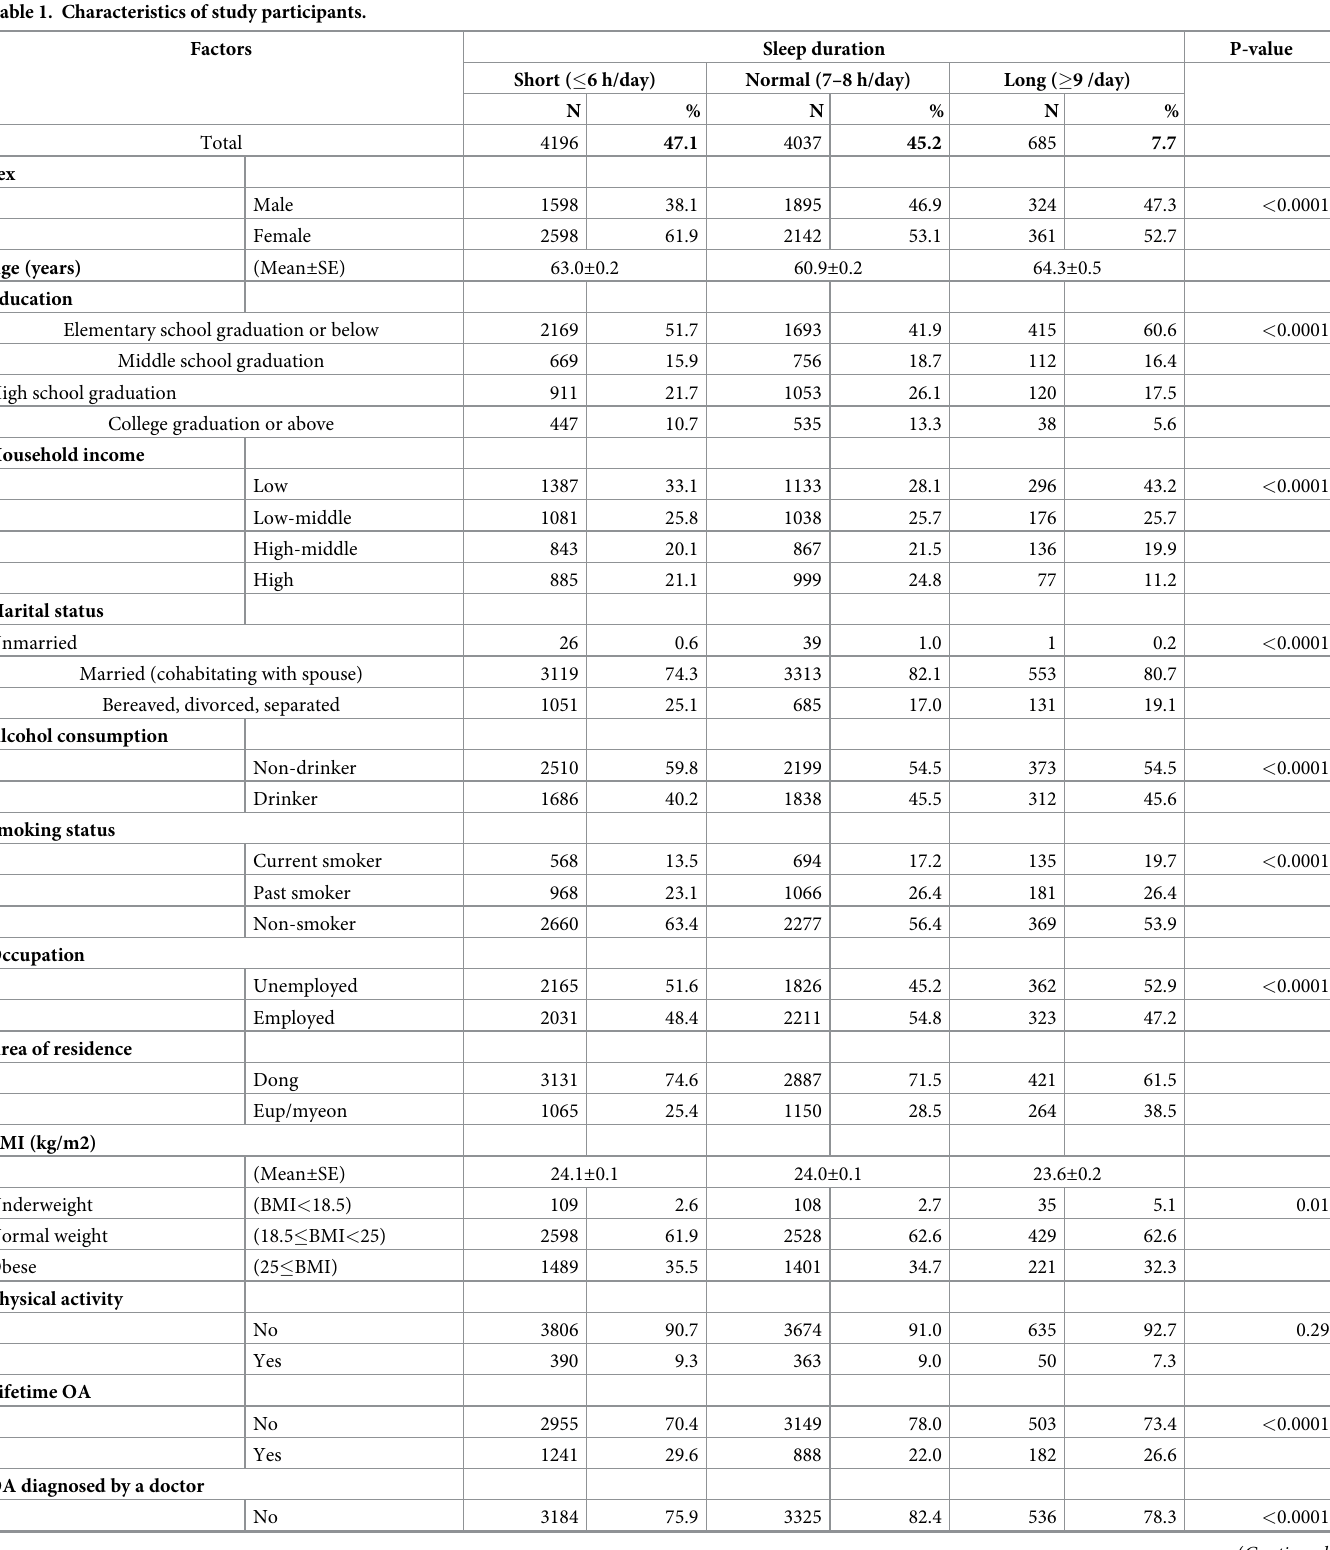
Table 1. Characteristics of study